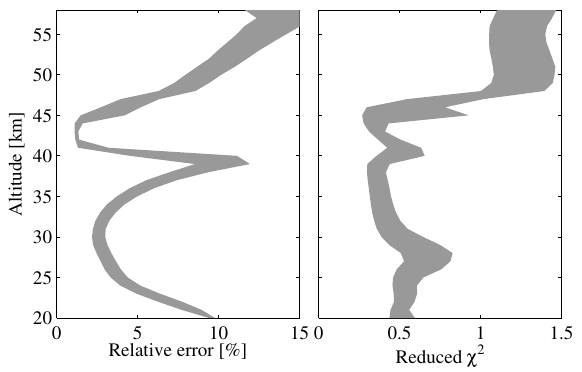
Figure 1. Interquartile range of the relative error (left) and reduced χ 2 (right). Data from the tropics, year 2004.